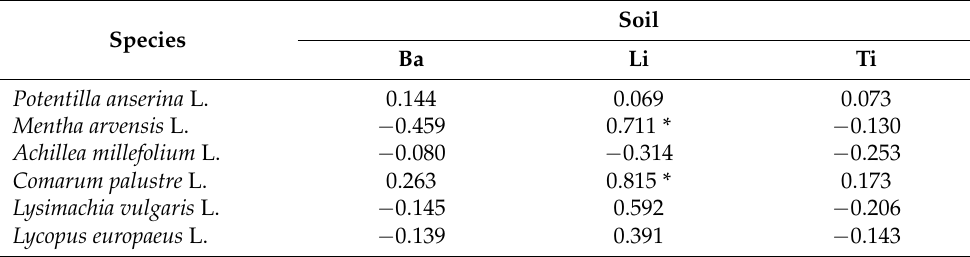
Table 9. Linear correlation coefficient between the Ba, Li and Ti content of the soil and of herb biomass. Soil Species Ba Li Ti Potentilla anserina L. 0.144 0.069 0.073 Mentha arvensis L. − 0.459 0.711 * −